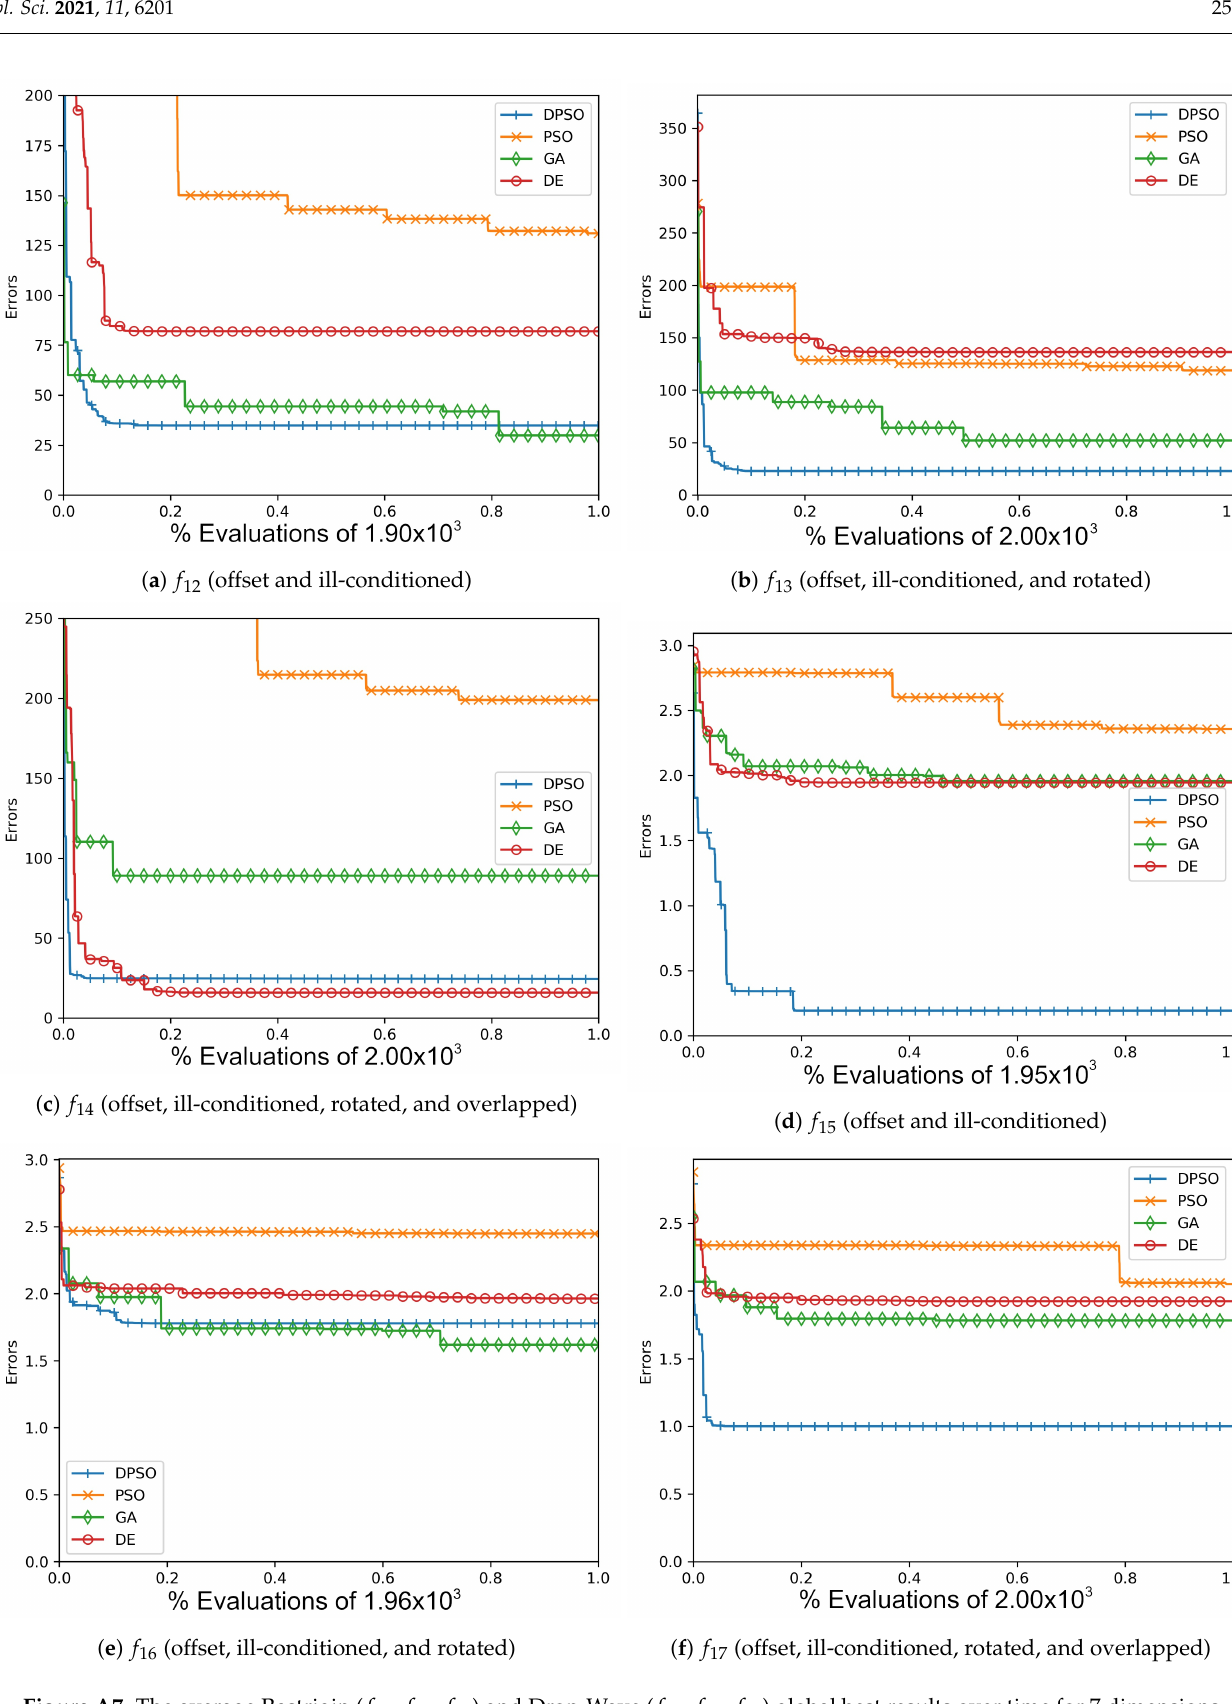
Figure A7. The average Rastrigin ( f 12 , f 13 , f 14 ) and Drop-Wave ( f 15 , f 16 , f 17 ) global best results over time for 7